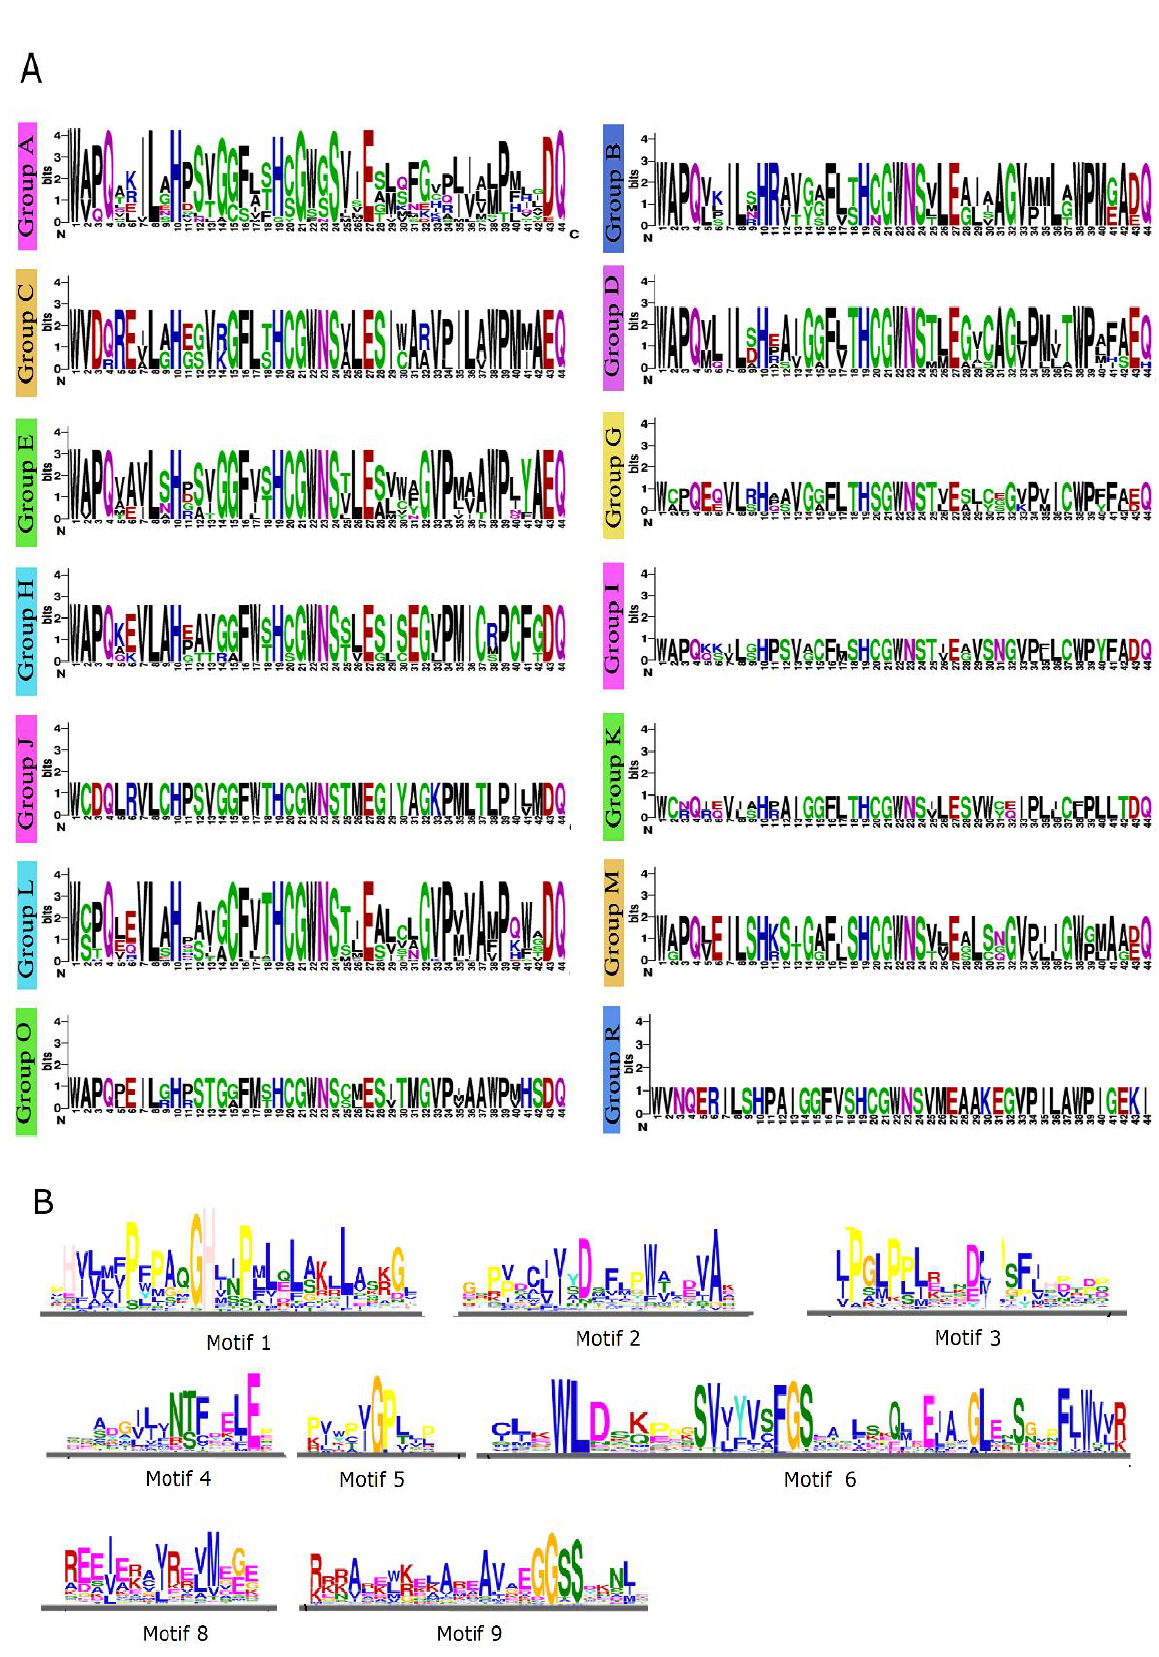
Figure 3. Conservative motifs of Eu UGTs. ( A ) The Weblogo of motifs of motif 7 (PSPG box) in each phylogenetic group of Eu UGTs; ( B ) the Weblogo of the other motifs in Eu UGTs.